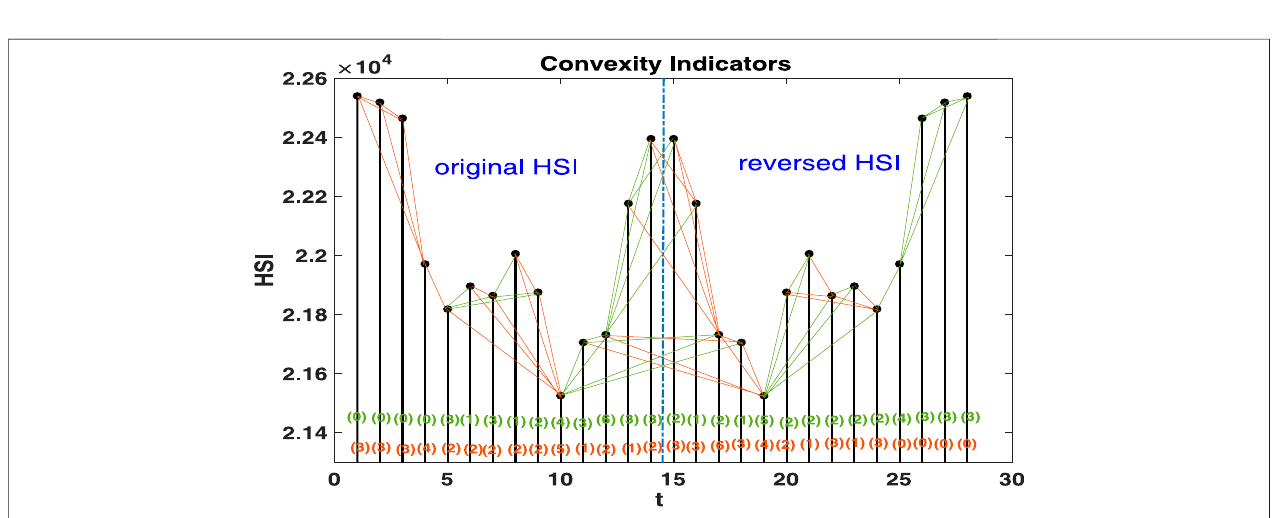
FIGURE2| Applicationofthemodi fi edIVGAtothedailyHangSengIndexfromAugust13,2013,toSeptember2,2013,anditstime-reverselymirroreddata.Note that perfect re fl ectional symmetry between DR [nodes 5 – 8 in (A) ] and AF [nodes 6 – 10 in (B) ] is demonstrated via identically distributed degrees in the two networks.